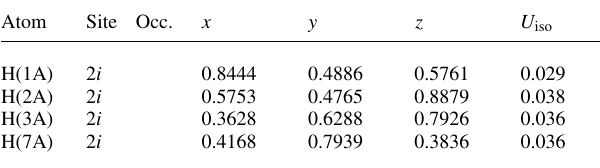
Table 2. Atomic coordinates and displacement parameters (in Å 2 )